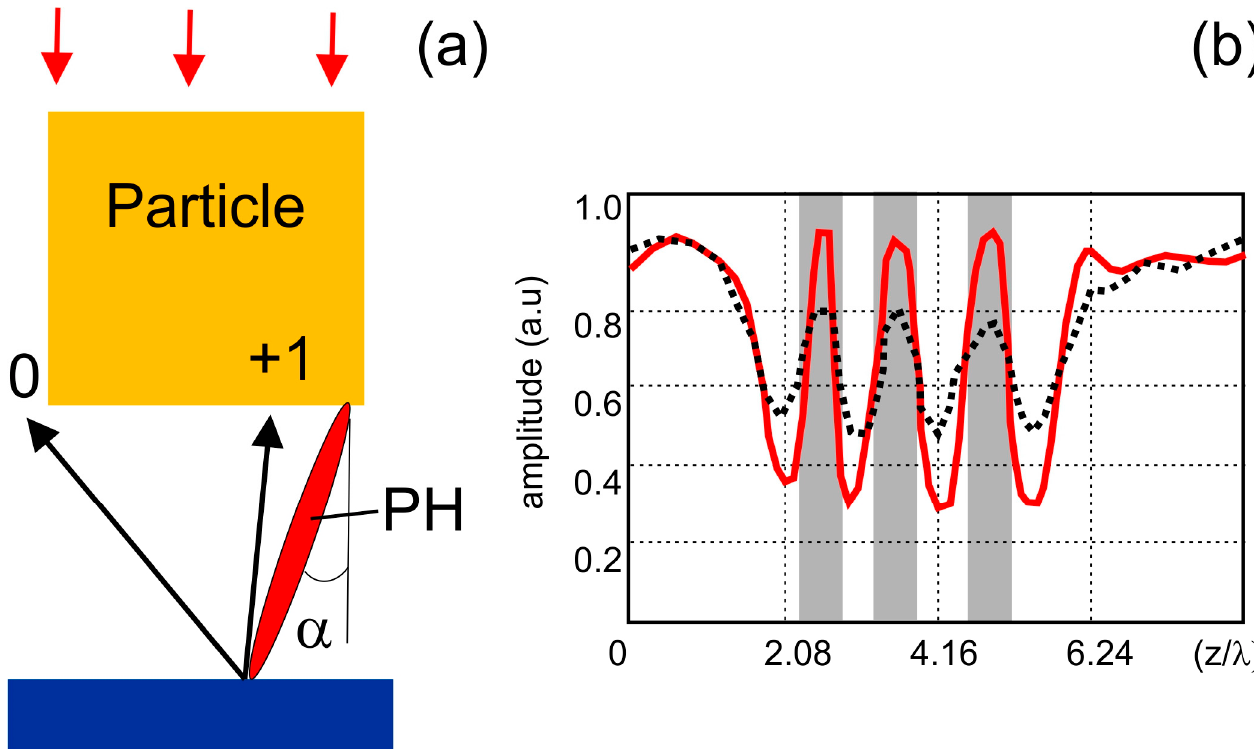
Figure 4. Schematic view of the oblique illumination by a photonic hook ( a ) and the imaging contrast enhancement of periodic metallic grating (shown in gray) ( b ) by the illumination of PBJ (black) and PH (red). Adapted from [95].